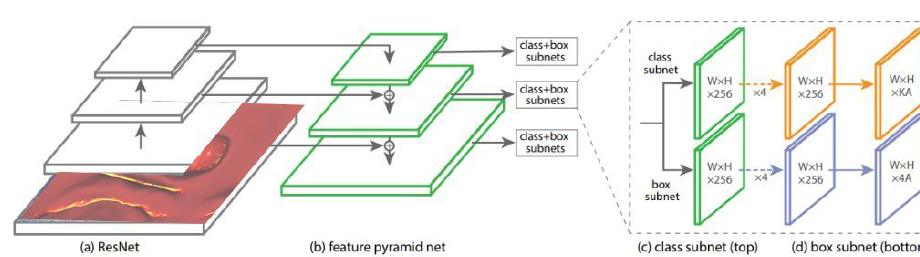
Figure 6. RetinaNet Model